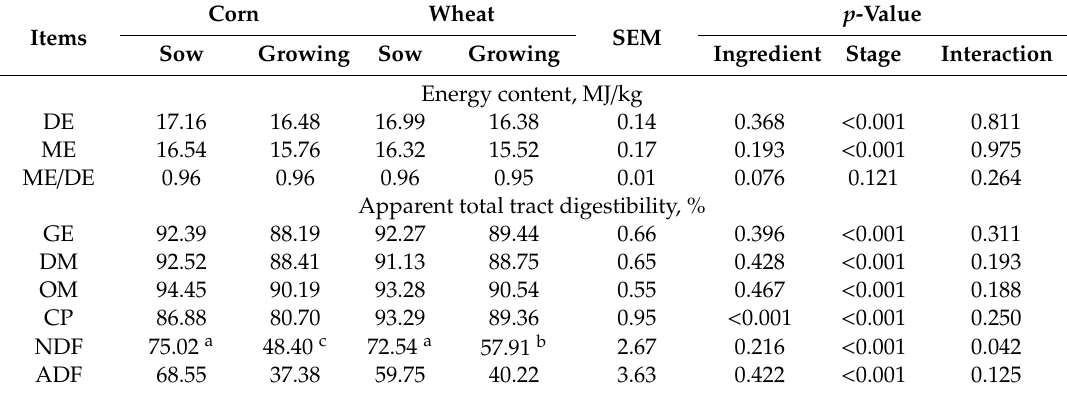
Table 3. Comparative energy and nutrient utilization in cereal ingredients by adult sows and growing pigs 1 (dry matter basis).